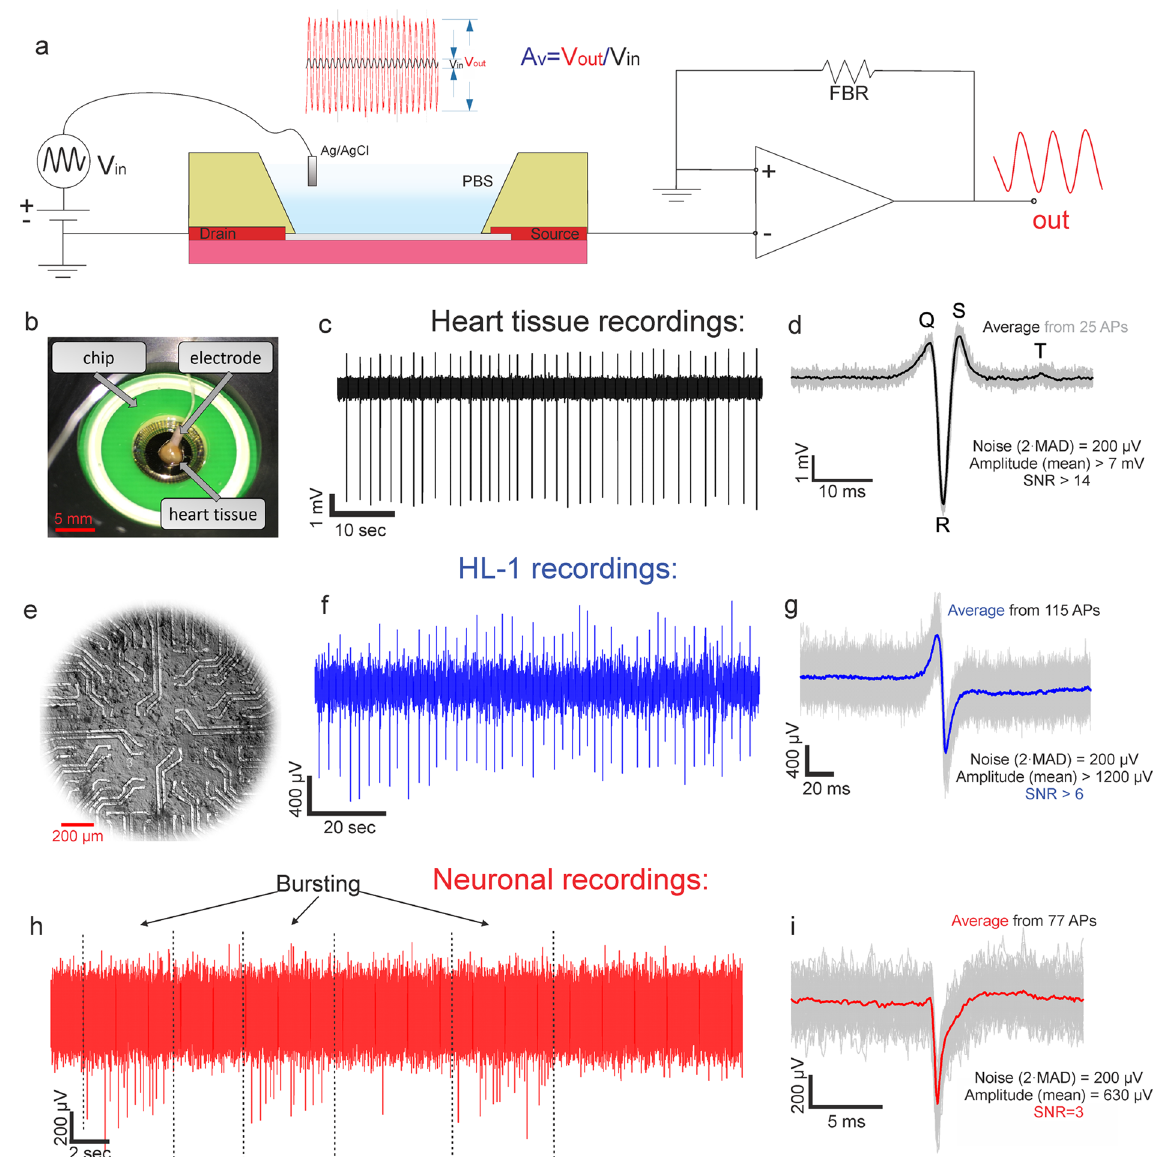
Figure 6. ( a ) Simplified schematics of the multichannel measurement set-up. Not to scale. ( b ) A photograph of the heart tissue on top of the chip’s surface while recording. ( c ) The time trace from one of the GFETs showing large (up to 8 mV amplitude) and frequent (40 bpm) APs. ( d ) The AP, averaged from 25 consecutive spikes with visible Q, R, S and T modes. ( e ) An optical micrograph of an HL-1 cell culture on top of a GFET chip. ( f ) A typical time trace recording of HL-1 activity recorded with a graphene transistor. ( g ) The averaged HL-1 spikes (blue) from 115 individual consecutive spikes from the chip. ( h ) The neuronal recording time trace with the inherent neuronal feature of bursting, when the neurons exhibit alternating periods of high frequency (bursts) and low frequency, intermittent, spiking. ( i ) The averaged AP (red) from 77 individual APs (gray) from the neuronal time